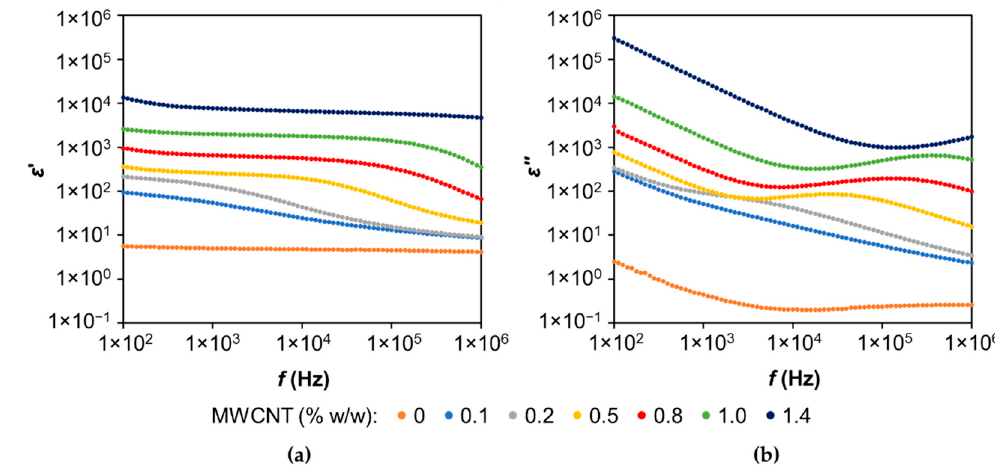
Figure 7. Real ε (cid:48) ( a ) and imaginary ε ” ( b ) parts of complex permittivity, ε *( f ) = ε (cid:48) ( f ) − i ε ”( f ) as a Figure 7. Real ε ′ ( a ) and imaginary ε ″ ( b ) parts of complex permittivity, ε *( f ) = ε ′ ( f ) − i ε ″ ( f ) as a func- function of frequency, at T = 77 ◦ C for LS-based polymer undoped and doped with different amounts tion of frequency, at T = 77 °C for LS-based polymer undoped and doped with different amounts of MWCNTs. of